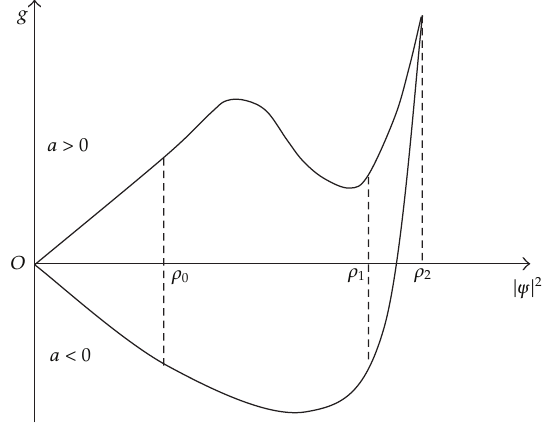
Figure 4: Function g for a